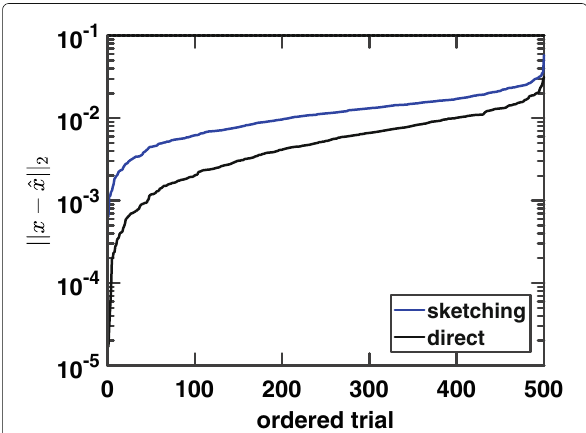
Fig. 7 Covariance sketching as initialization for Info-Greedy Sensing. Sorted estimation error in 500 trials. In this example, signal dimension n = 10, there are m = 40 sketches; thus, the dimensional reduction ratio is 40 / 10 2 = 0.4. The errors of covariance sketching are higher than using the direct covariance estimation as initialization (to achieve the goal of dimensionality reduction); however, note that the errors of covariance sketching are still much below the pre-specified error tolerance (cid:18) = 0.1 and thus are